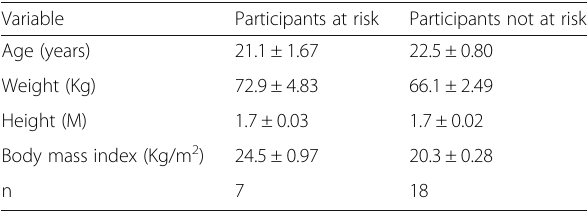
Table 2 Anthropometric data of both groups (participants at risk and those not at risk) Variable